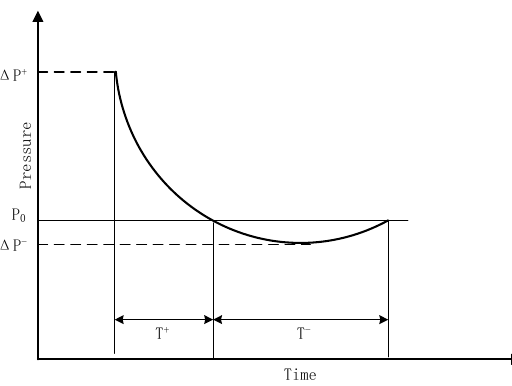
Figure 1. Explosion shock wave overpressure decays with distance.